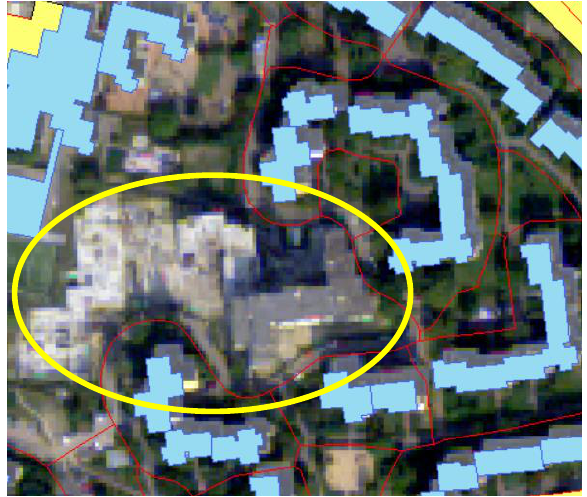
Figure 1. High buildings in dense urban area (test site “U”), the new ones indicated within yellow circle.